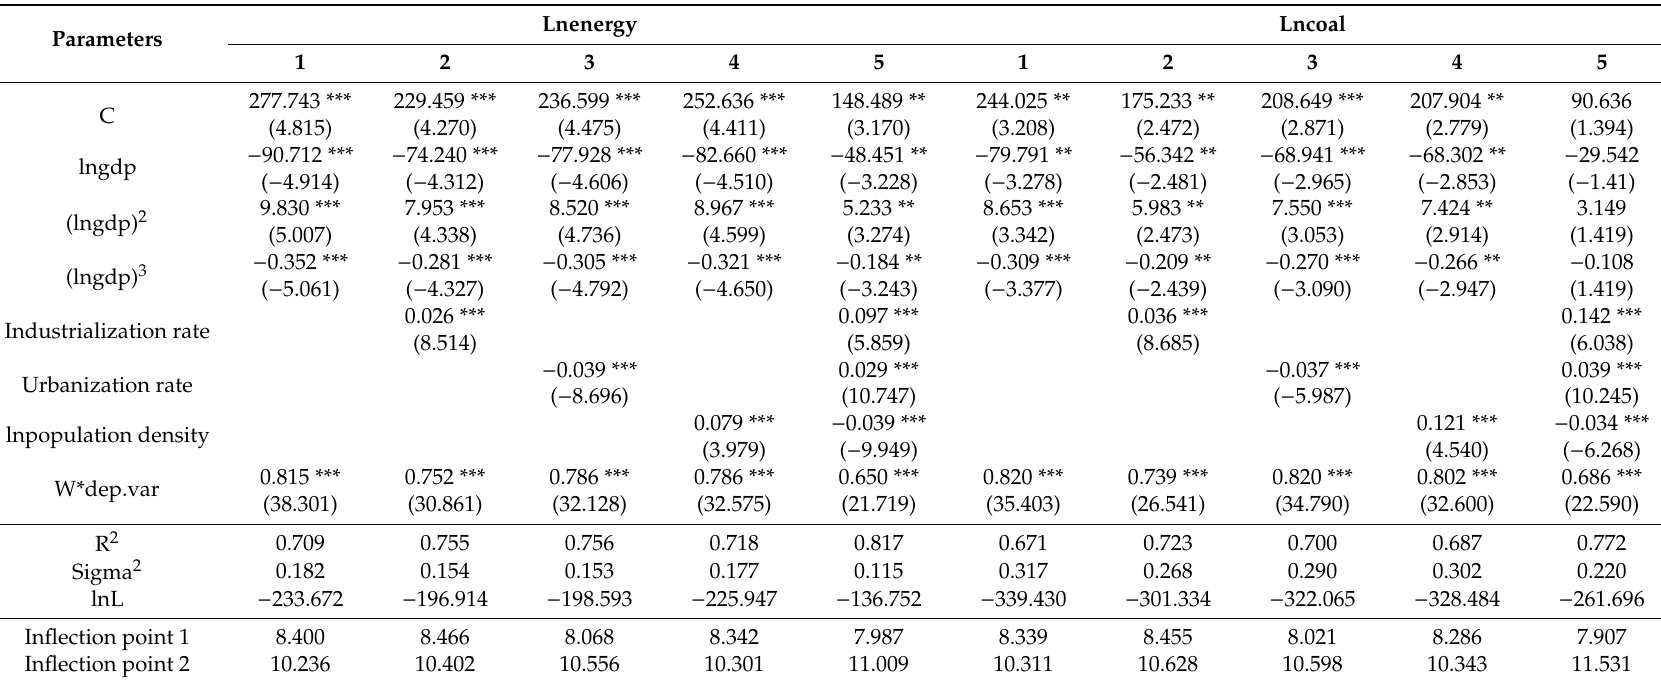
Table 6. Spatial lag model estimation results of total energy consumption and total coal consumption mixed OLS e ff